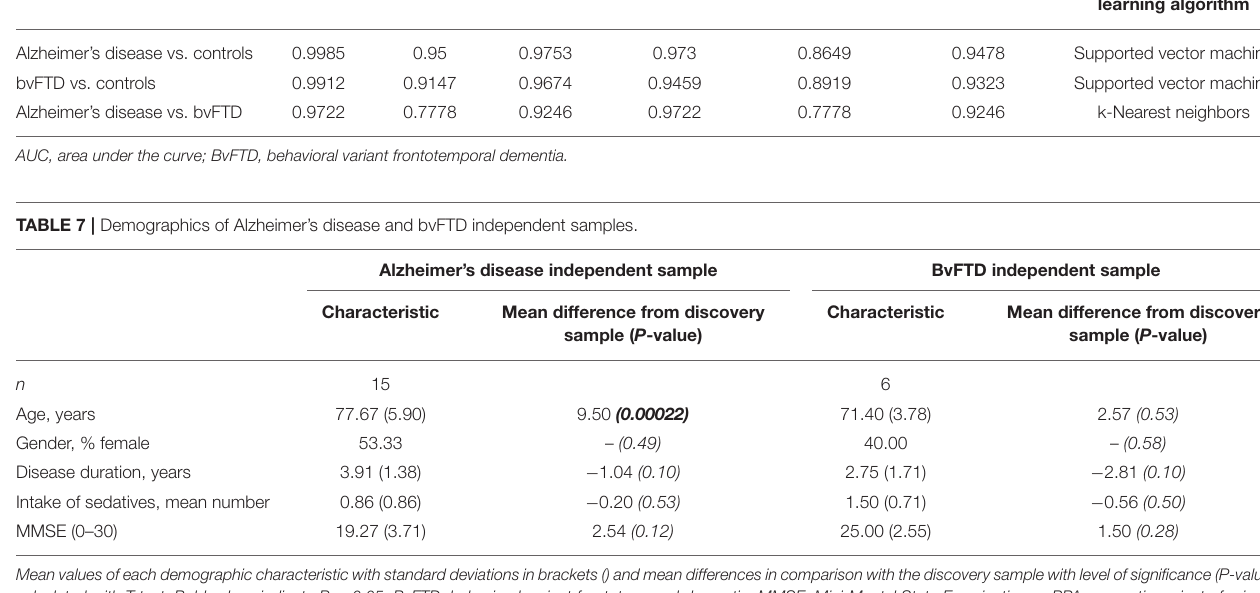
TABLE 6 | Performance of the machine learning classifiers. Pairs of groups Selected machine Alzheimer’s disease vs. controls bvFTD vs. controls